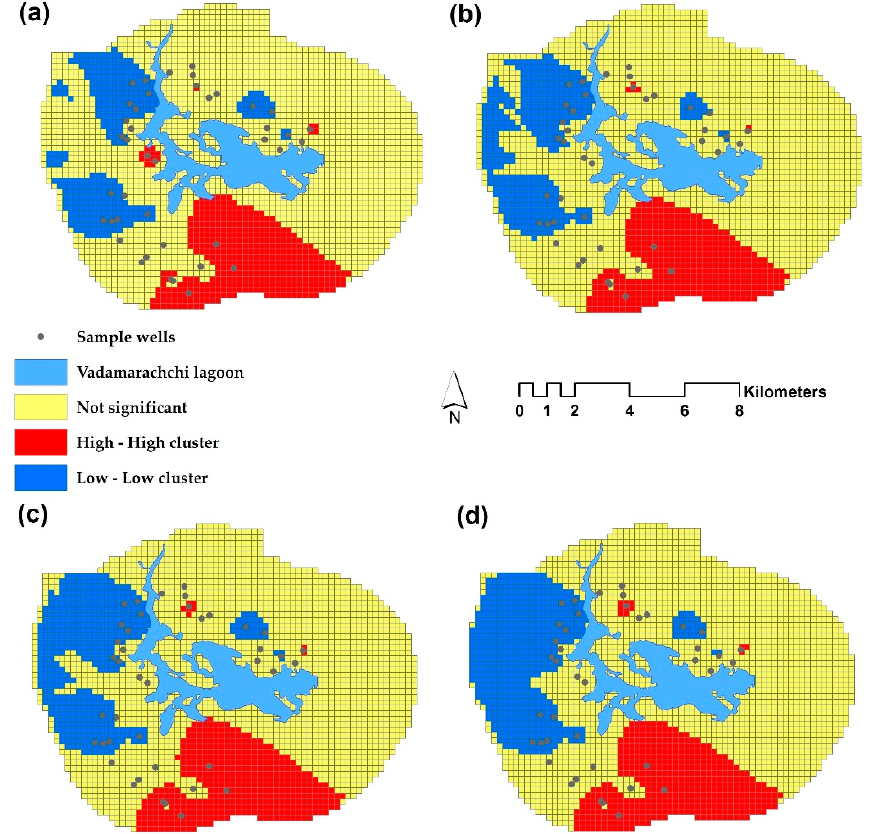
Figure 8. The spatial pattern of local indicators of spatial autocorrelations clusters of electrical conductivity during the dry season: ( a ) March, ( b ) April, ( c ) May, and ( d ) June.